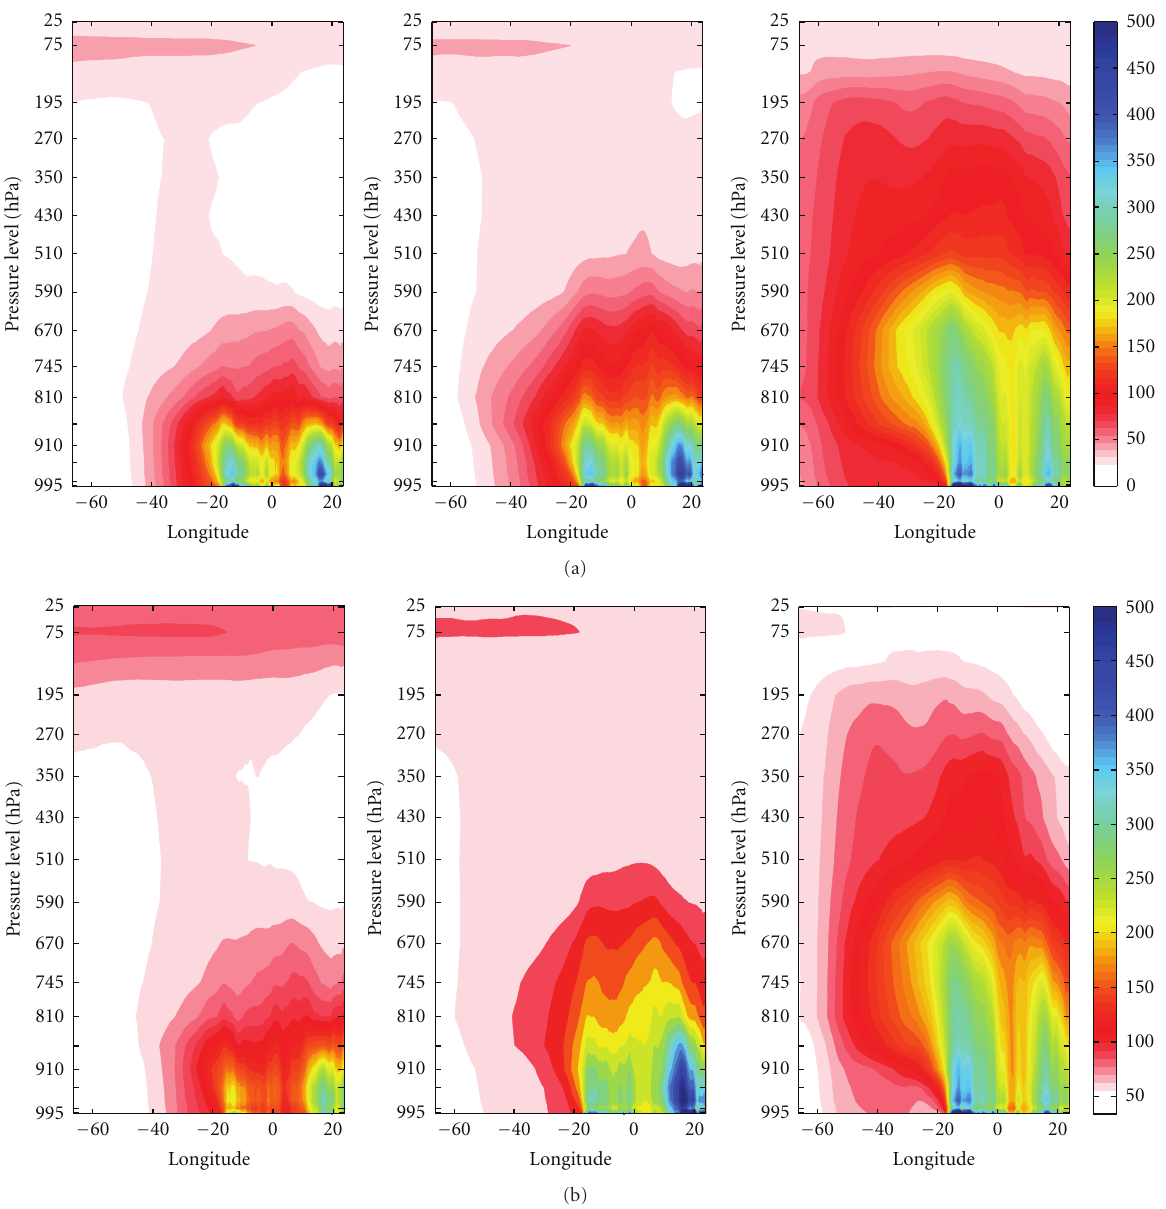
Figure 9: Zonal profile of mean desert dust concentrations in μ g/kg in the troposphere average between 0 ◦ N and 25 ◦ N for the periods “December-January-February (DJF),” “March-April-May (MAM),” and “June-July-August (JJA)”: (a) mean values for the years 2005–2010; (b) mean values for 2010. Higher concentrations are indicated with cool colors and lower concentrations with hot colors.